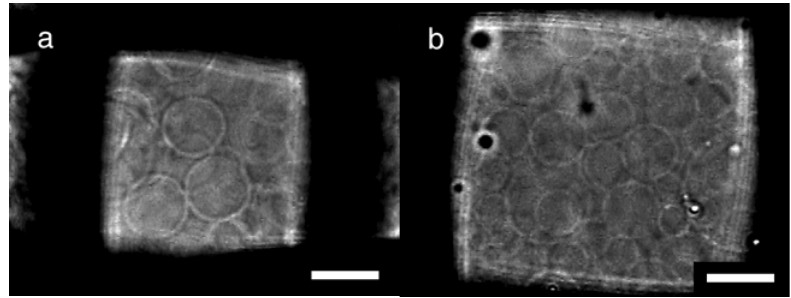
Figure 3. (a) GV formation on a nylon mesh #196 with sinusoidal ac voltage (5.0 Vpp, 2 Hz) at 70 min; (b) A nylon mesh #145 at 100 min. Bar = 20